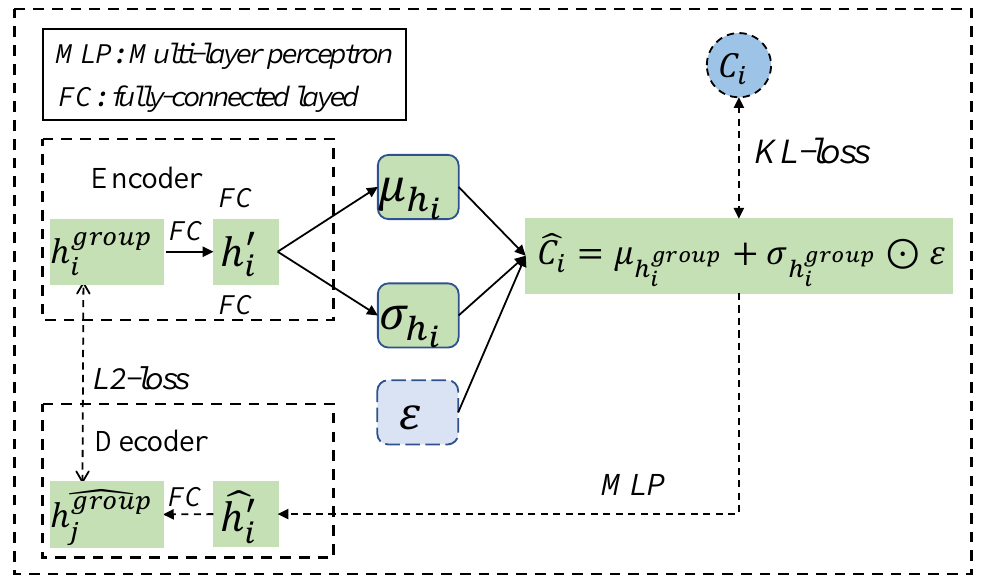
Figure 3. Architecture of variational autoencode. The agent understanding for the environment is obtained via variational autoencoder (VAE). L2-loss is the reconstruction loss function and KL-Loss is the loss function for VAE